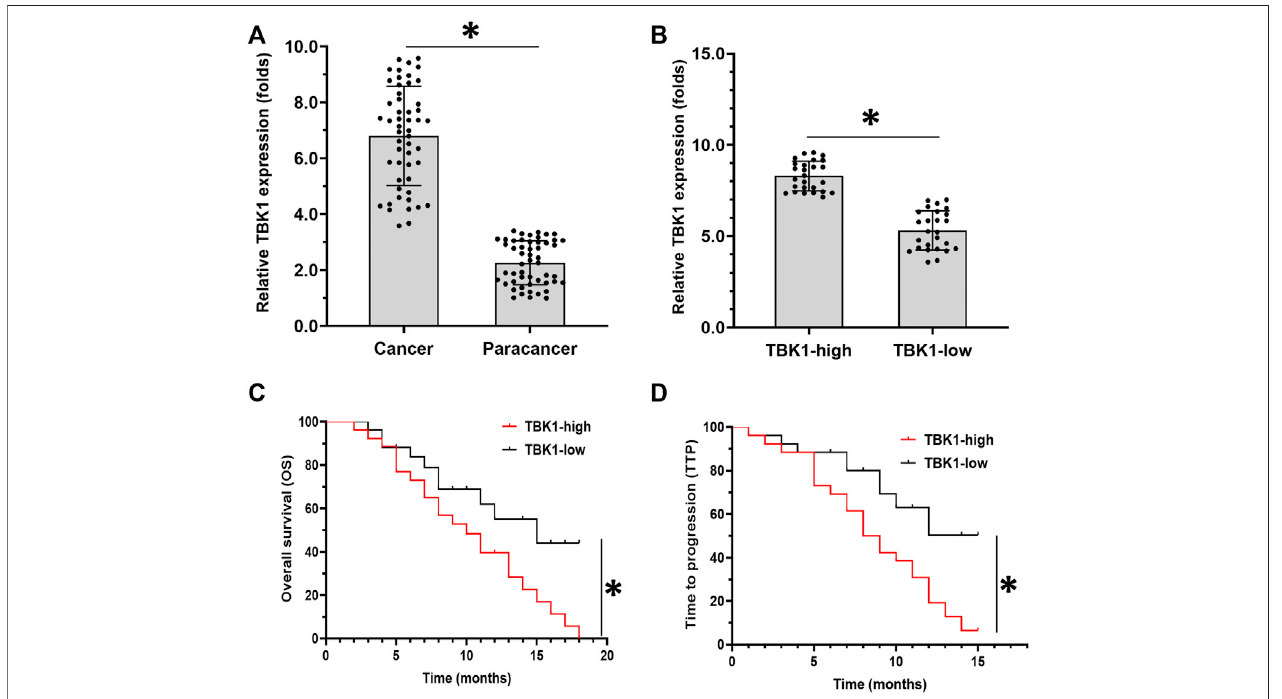
FIGURE1| The clinicalsigni fi cance of TBK1 inHCC. (A) The expression of TBK1 inHCC clinical specimensor paired non-tumor tissues (non-tumor regions ofthe liver in the HCC patients). (B) The median value of TBK1 in patients in the TBK1 -high group or the TBK1 -low group. (C,D) The OS (overall survival) or TTP (time to progress) of the patients in the TBK1 -high group or the TBK1 -low group who received sorafenib treatment. p p < 0.05.